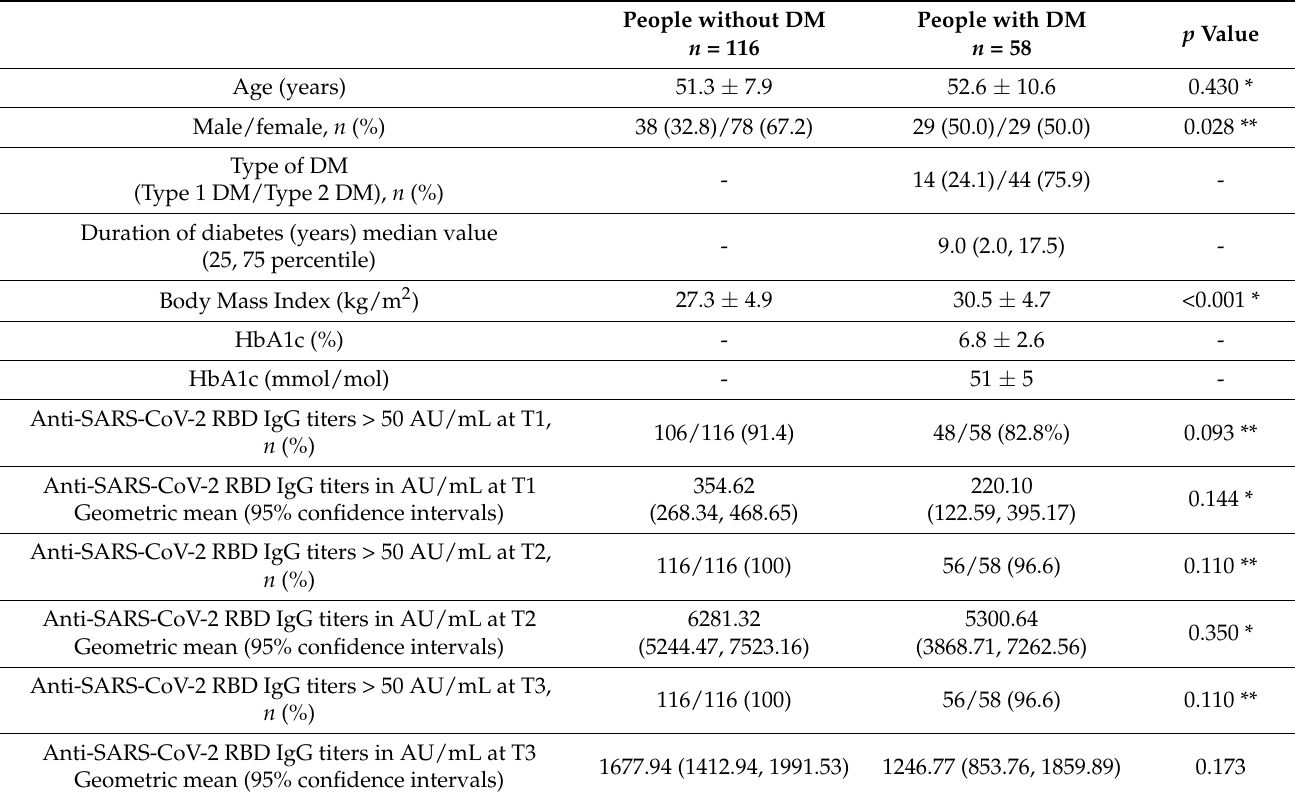
Table 1. Characteristics and humoral immune response of the study participants.